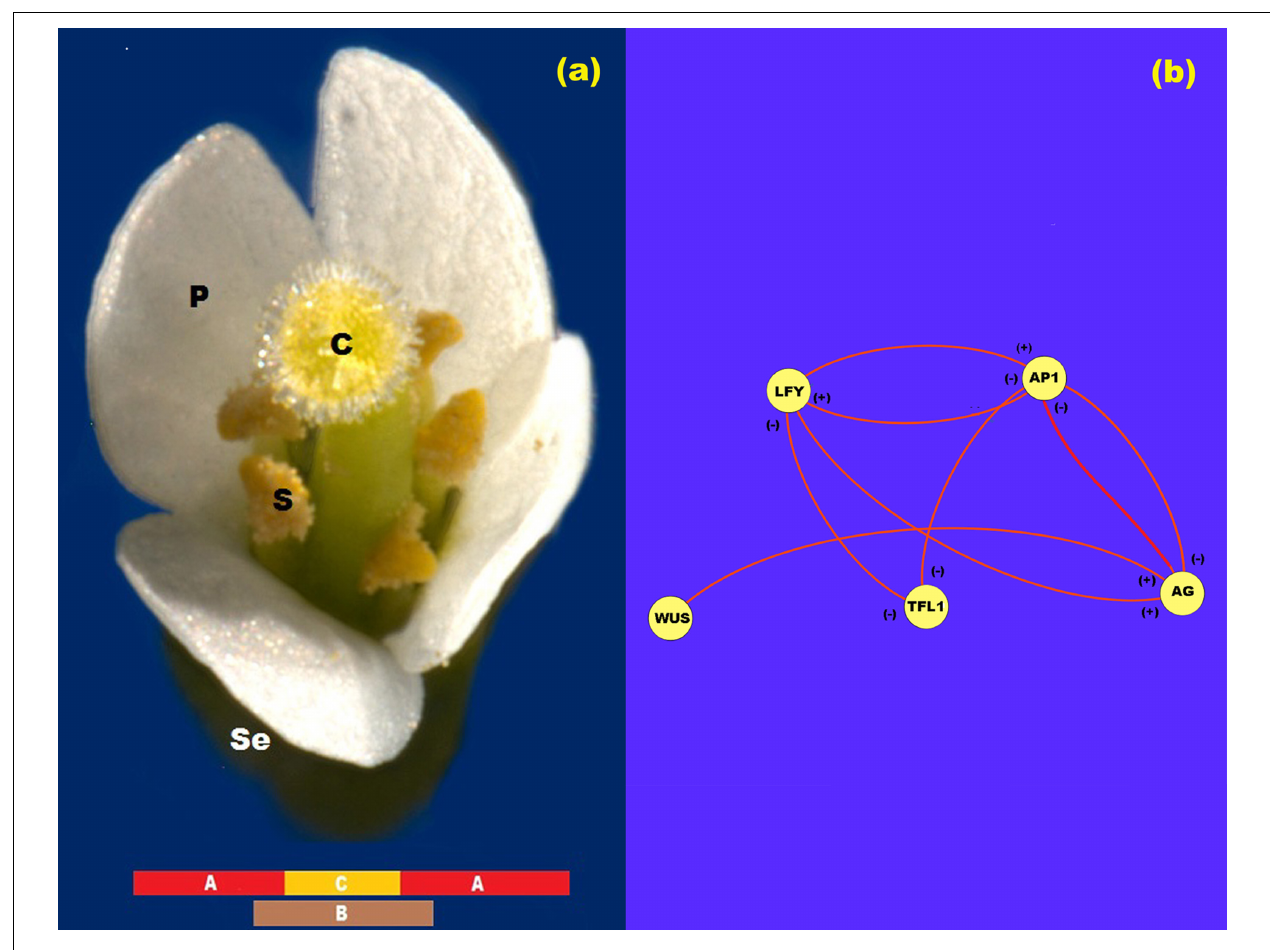
FIGURE 1 | ABC model of flowering. (a) ABC model of flowering for Arabidopsis. In this figure se: sepals; p: petals; s: stamen; and c: carpel. (b) Network representation of the interaction between the proteins LFY, AP1, TFL1, AG, and WUS. In this Figure (+) represents activation and (-) represents